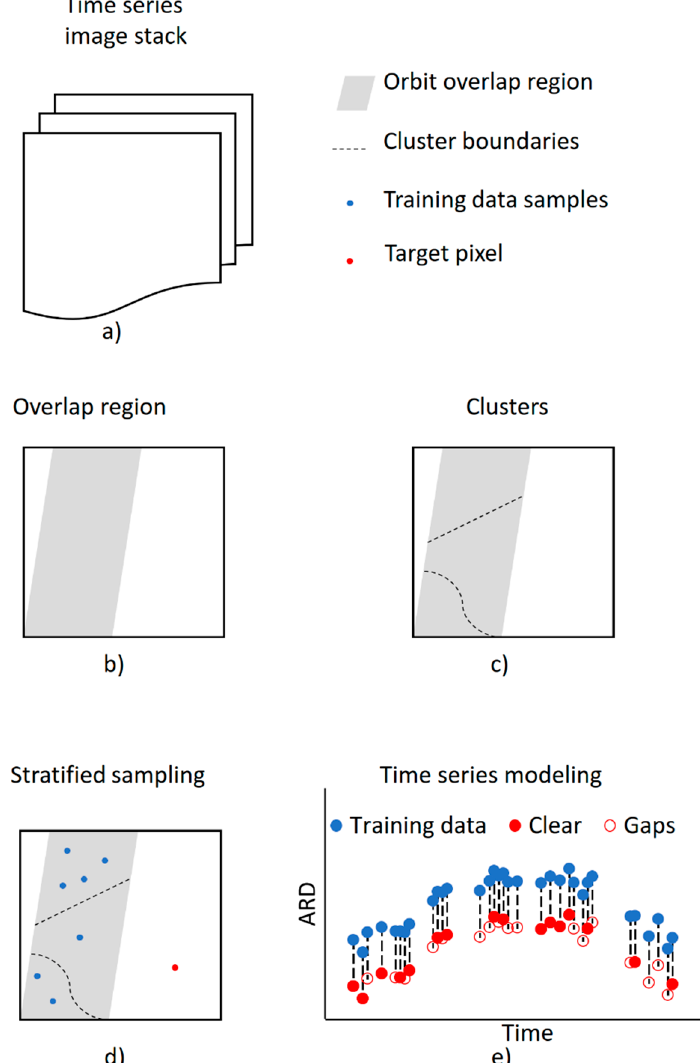
Figure 2. Illustration of the conceptual approach of gap filling. ( a ) The time series images with non-clear observations masked. ( b ) The orbit overlap region with a high density of clear observations. ( c ) The clustered training data depending on time series similarity. ( d ) Stratified random samples for a target pixel depending on the time series similarity between the target pixel and cluster centers. ( e ) A regression model built using the clear observations of samples and the target pixel. The gaps in the target pixel are then predicted from the regression model.